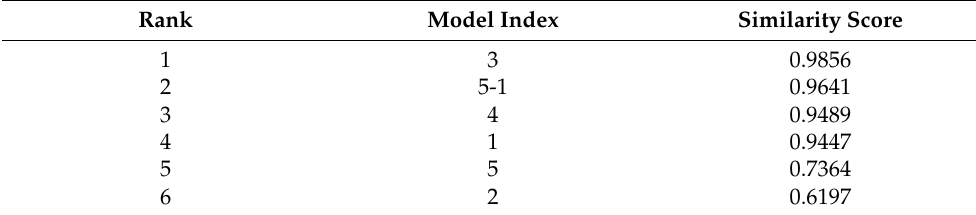
Table 5. Rankings of the 5-in-1 (ensemble) and top five WRF models in accordance with the similarity score as determined using the 4-day wind speed test dataset.